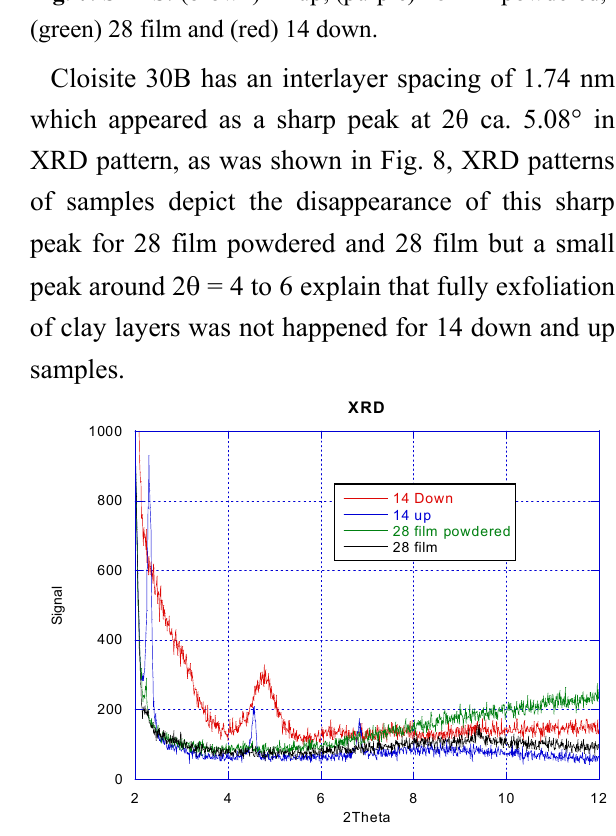
Fig. 8. XRD profiles for all 4